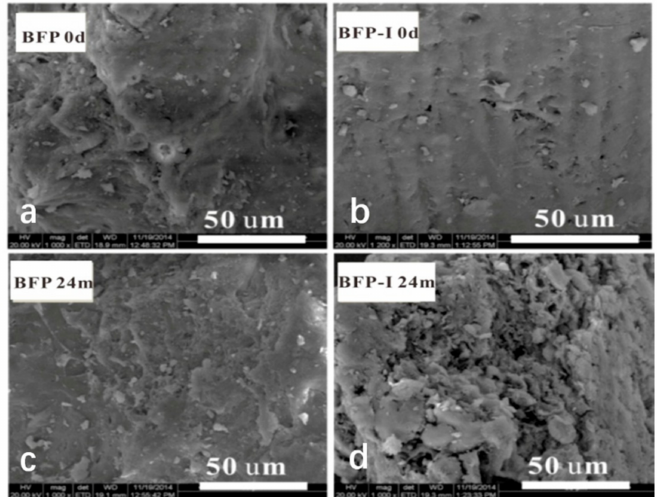
Figure 4. Surface morphology of the BFP and BFP-I composites. Note: ( a ) BFP untreated; ( b ) BFP-I untreated; ( c ) BFP treated 24 months of degradation; ( d ) BFP-I treated 24 months of